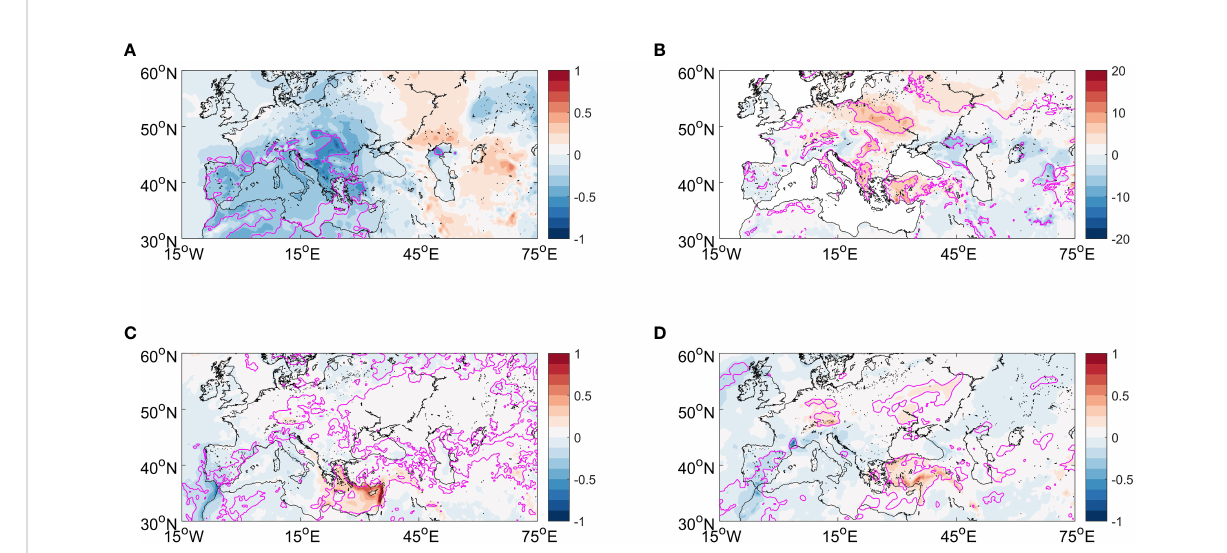
FIGURE 10 The lagged regressions of (A) 2-m air temperature (shading; unit, °C), (B) snow cover (shading; unit, %), (C) convective precipitation (shading; unit, mm), and (D) large-scale precipitation (shading; unit, mm) in DJF onto the KEI 2 months earlier, with magenta contours representing the regions where anomalies pass the 90% con fi dence level. KEI, Kuroshio Extension